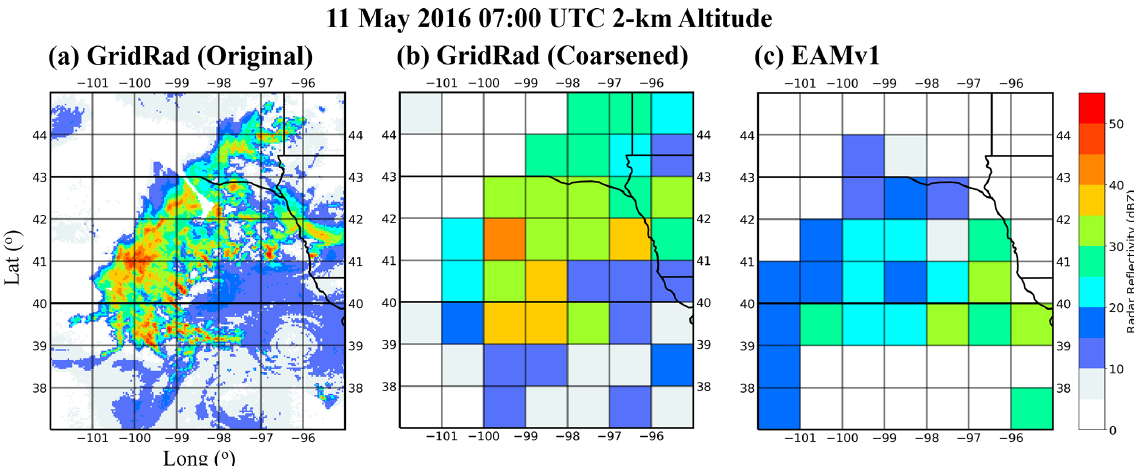
Figure 2. Examples of (a) original GridRad observation, (b) GridRad mapped over the E3SM model grid, and (c) the concurrent model simulation on 11 May 2016, 07:00UTC, at the 2km